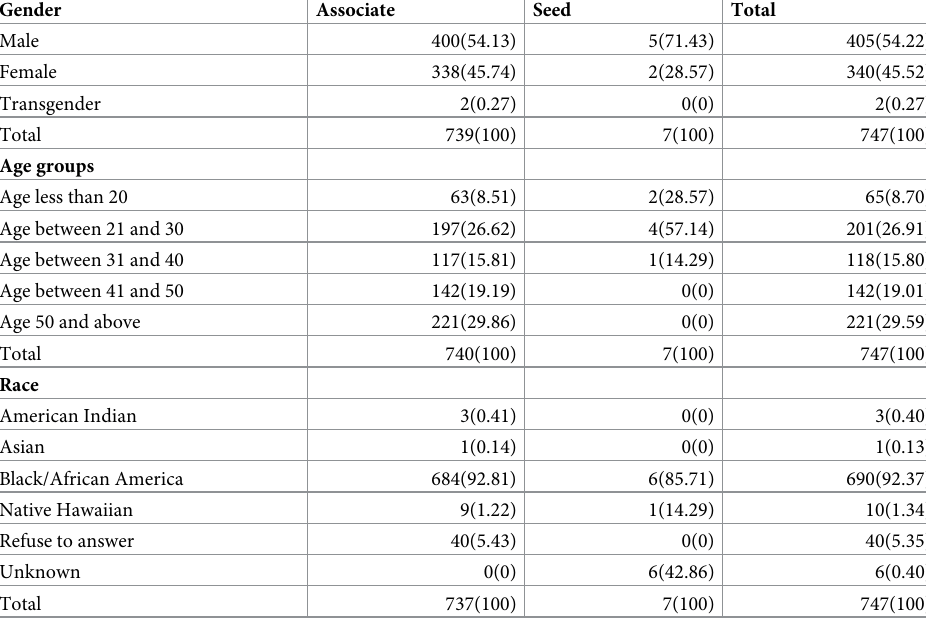
Table 2. Descriptive characteristics of HET cycle 4 of seeds and